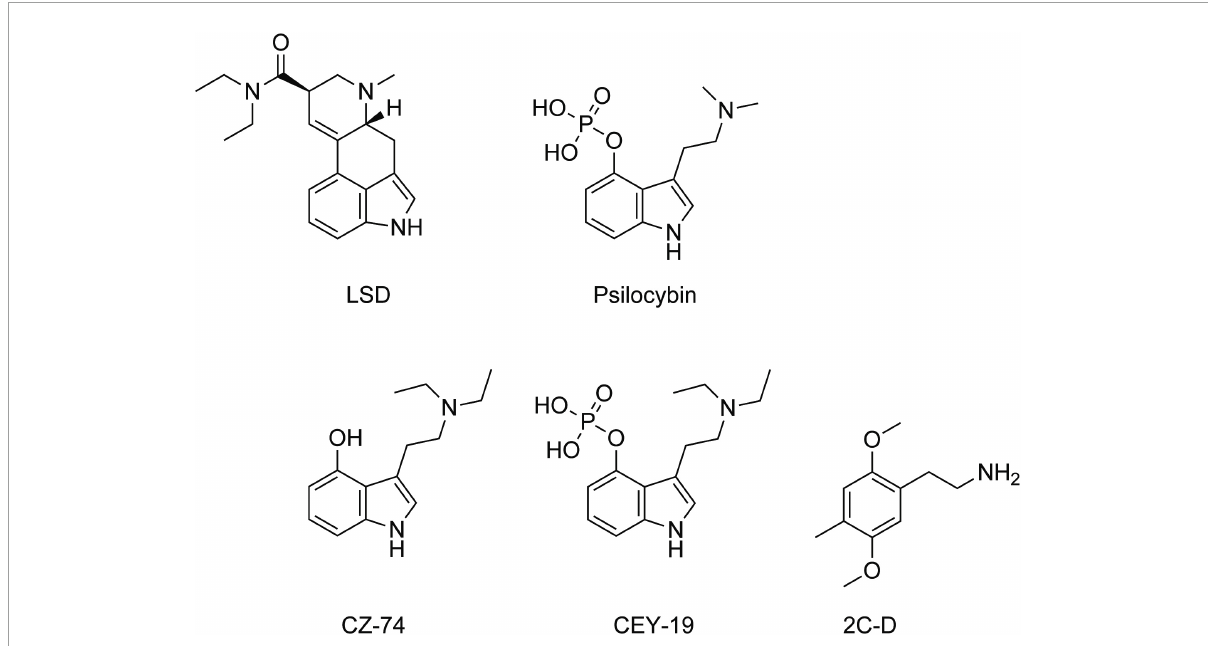
FIGURE1 Chemical structures of the main psycholytic substances lysergic acid diethylamide (LSD), psilocybin, the psilocin derivatives CEY-19, CZ-74, and the phenethylamine 2C-D.